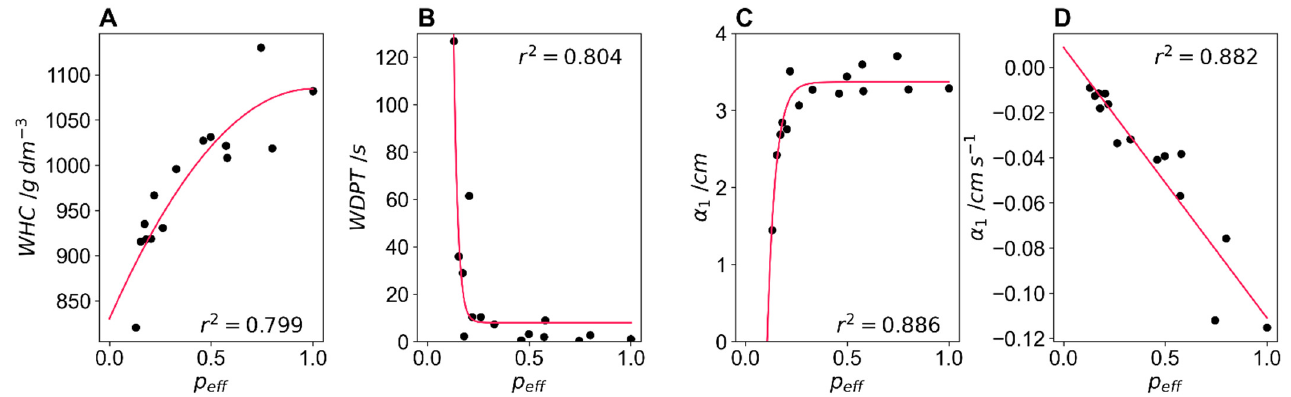
Figure 11. ( A ) The water holding capacity (WHC) as a function of effective open cell fraction with the solid line indicating a quadratic fit to the data. ( B ) The water drop penetration time (WDPT) as a function of the effective open cell content with the solid line indicating an exponential fit of the data. ( C ) The maximum capillary rise ( α 1 ) as a function of the open cell content with the solid line indicating an exponential fit to the data and ( D ) the rate of water uptake ( α 2 ) as a function of the effective open cell fraction with the solid line indicating a linear fit to the data.